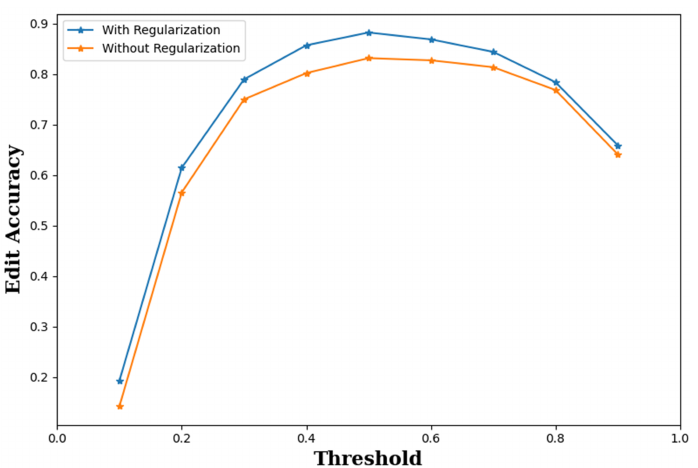
Figure 9. The average EDA of the proposed algorithm with and without regularization. We set = 750, ∆ = 1 and r = 0.3 for the implementation of the proposed M TR